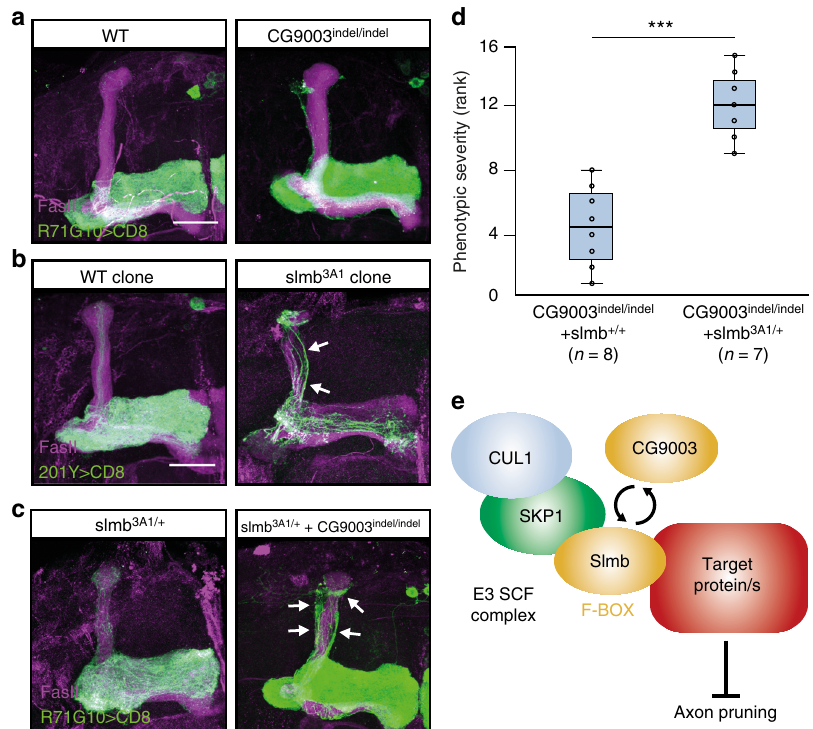
Fig. 4 The F-BOX protein CG9003 is important for MB pruning. a Confocal Z-projections of MBs of adult fl ies that are either WT or homozygous for CG9003 indel . CD8 is driven by R71G10-GAL4 . b Confocal Z-projections of WT or slmb3A1 MB neuroblast MARCM clones, labeled by CD8 driven by 201Y- GAL4 . c Confocal Z-projections of MBs of adult fl ies that are heterozygous for the slmb3A1 mutation, and in addition either WT in the CG9003 gene (left) or homozygous for the CG9003 indel mutation (right). CD8 is driven by R71G10-GAL4 . d Boxplot depicting the rank of pruning defect severity of CG9003 indel homozygotes without or with slmb3A1 heterozygosity. The box represents the fi rst to third quartiles, whiskers represent minimum and maximum values within 1.5× interquartile range, the horizontal line represents the median, and empty circles represent all values within the group. Mann – Whitney U test: W = 0, *** p < 0.001. For simplicity, the plot only displays results from one ranker, and the results of the second ranker are presented in Supplementary Fig. 4d. e Schematic suggested model of the function of F-BOX proteins CG9003 and Slmb in MB γ axon pruning. Either Slmb or CG9003 can function as the F-BOX protein of the SCF complex, and either of them can bind a shared substrate whose degradation is essential for proper execution of pruning. In all confocal images, scale bar represents 30 µ m. White arrows highlight unpruned γ axons. CD8, green; FasII, magenta. Source data are provided as a Source Data fi